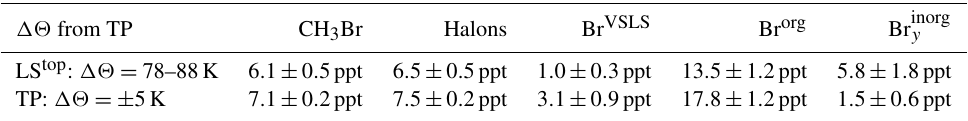
Table 4. The average bromine mixing ratios of CH 3 Br, halons, Br VSLS , Br org (CH 3 Br + halons + Br VSLS ), and Br inorg y near the TP ( (cid:49)(cid:50) = ± 5K) and in the upper layer of the lower stratospheric WISE measurements, labeled LS top ( (cid:49)(cid:50) = 78–88K). (cid:49)(cid:50) from TP CH 3 Br Halons Br VSLS Br org Br inorg y LS top : (cid:49)(cid:50) = 78–88K 6 . 1 ± 0 . 5ppt 6 . 5 ± 0 . 5ppt 1 . 0 ± 0 . 3ppt 13 . 5 ± 1 . 2ppt 5 . 8 ± 1 . 8ppt TP: (cid:49)(cid:50) = ± 5K 7 . 1 ± 0 . 2ppt 7 . 5 ± 0 . 2ppt 3 . 1 ± 0 . 9ppt 17 . 8 ± 1 . 2ppt 1 . 5 ± 0 .